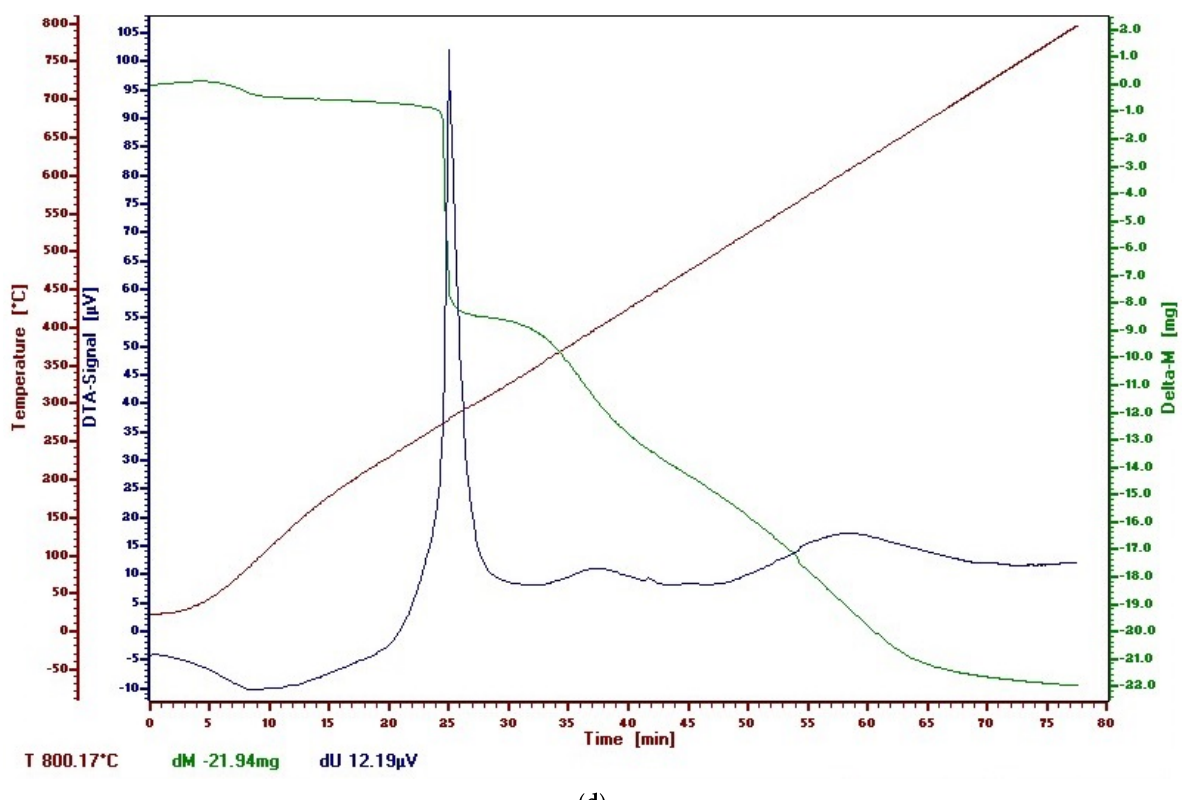
Figure 14. Experimental TG and DTA curves for acrylic polymers: control sample Melana ( a ), functionalized Melana ( b ), control sample Dralon L ( c ), functionalized Dralon L ( d ).